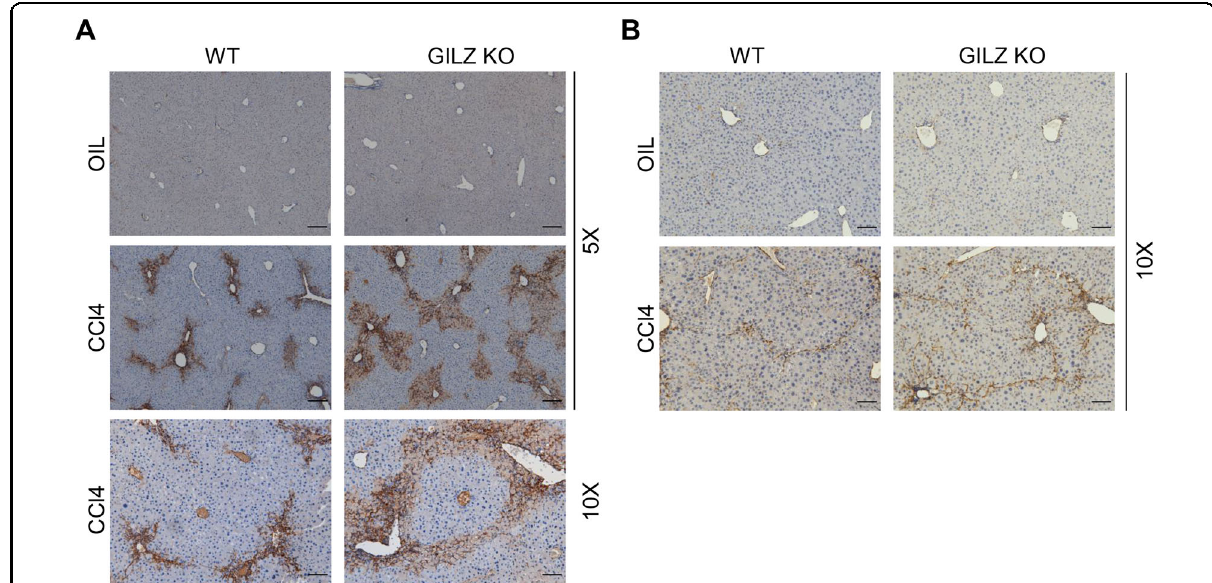
Fig. 2 GILZ de fi ciency is associated with elevated HSC activation. A , B Immunohistochemical analysis of α -SMA expression in the liver sections of WT and GILZ KO mice that had been treated with oil or CCl 4 for 72 h ( A ) or 7 weeks ( B ). Original magni fi cation, 5× or 10×, as indicated. Arrows indicate the areas of α -SMA positivity. Scale bar, 100 μ m (5× magni fi cation images) or 200 μ m (10× magni fi cation images).